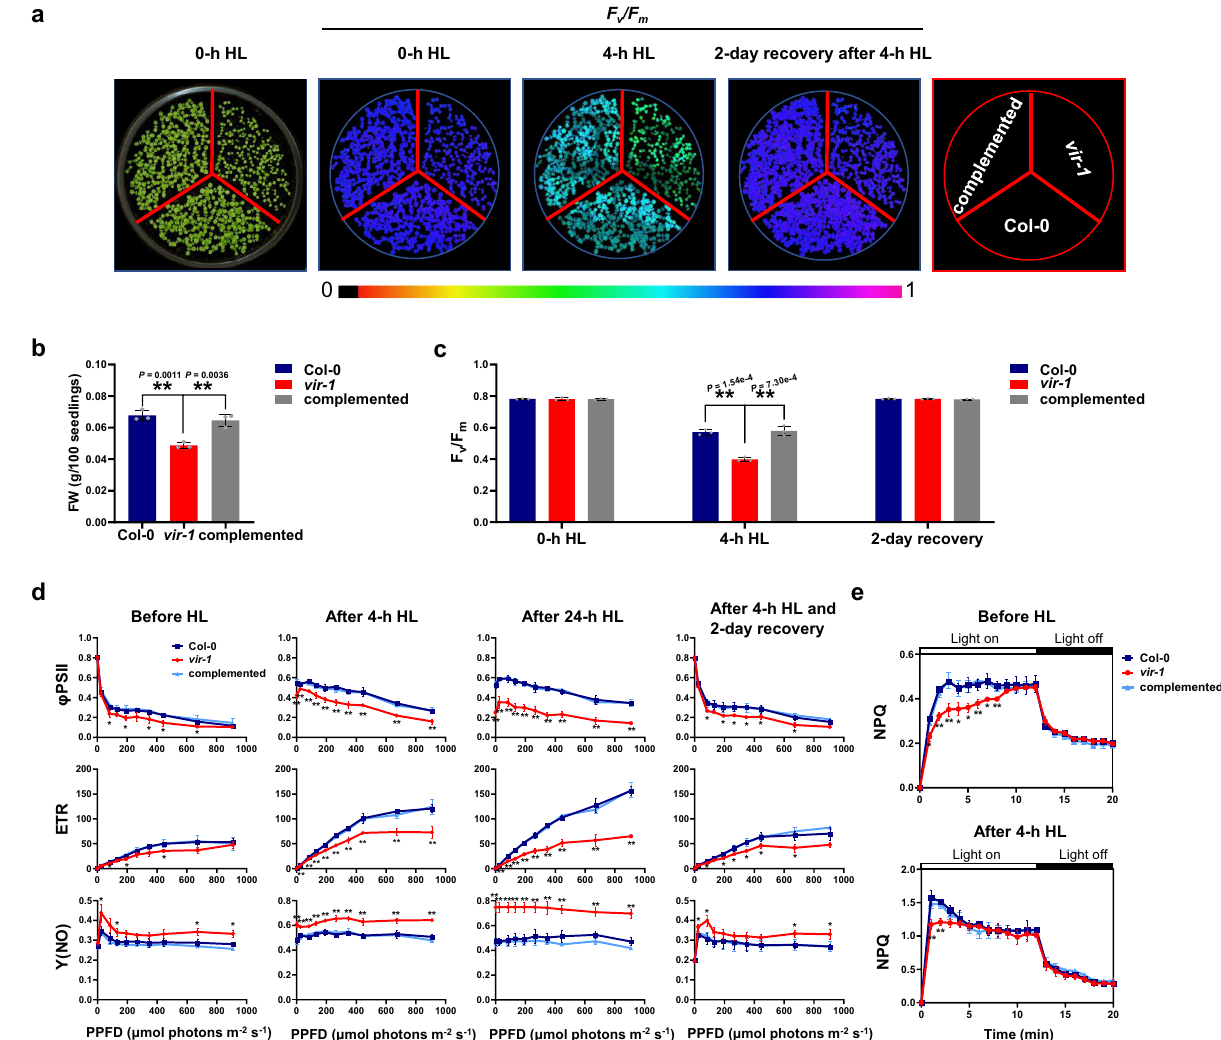
Fig.2|CharacterizationofphotosyntheticactivityinCol-0and vir-1 seedlings. a Left panel, image of 7-day-old Col-0, vir-1 , and VIR- complemented seedlings undernormalgrowthlight.Centerpanels, fl uorescenceimagesusedtomeasure F v / F m of seedlings grown under different light conditions. False-color images repre- senting F v /F m after 0 or 4-h high light (HL) treatment and 2-day recovery after 4-h HL treatment in Col-0, vir-1 , and complemented seedlings are shown. The false color ranges from black (0) to purple (1), as indicated in the scale at the bottom. b Freshweight(FW)of 7-day-old Col-0, vir-1 ,and complemented seedlings.Values are means±SE ( n =3 biological replicates). * P <0.05; ** P <0.01, by two-sided Stu- dent ’ s t test. c , Changes in F v /F m values for 7-day-old Col-0, vir-1 , and com- plemented seedlings under HL treatment. Values are means±SE ( n =3 biological replicates). * P <0.05; ** P <0.01, by two-sided Student ’ s t test. d Light-response curves of PSII quan t um yield ( Ф PSII), electron-transport rate (ETR), and non- regulated non-photochemical quenching yield [Y(NO)] in Col-0, vir-1 , and